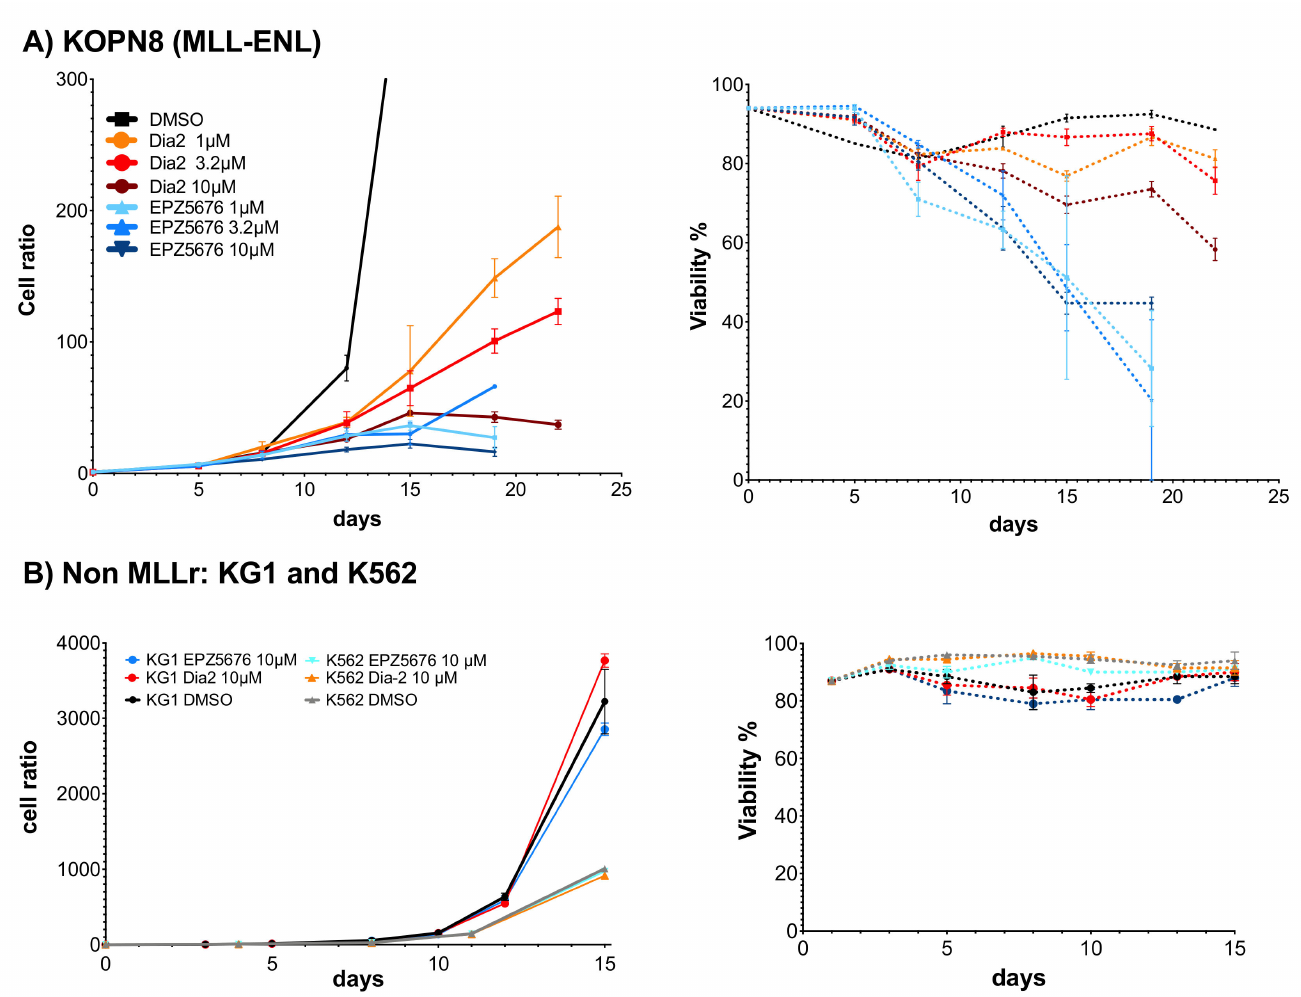
Figure 6. ( A ) Right, growth of KOPN8 cells (MLL-ENL) up to 22 days of incubation with 10 µ M (bordeaux red circles), 3.2 µ M (red circles), 1 µ M (orange circles), of Dia2 and 10 µ M (dark blue triangles), 3.2 µ M (cyan triangles), 1 µ M (sky blue triangles) of EPZ-5676 compared to DMSO treated cells (black squares) were plotted as the ratio amount of cells over initial population. Left, viable cells were counted every 3 to 4 days in the presence of Dia2 , EPZ-5676, or DMSO, and the percentage of viability is reported as dotted curves. Every data point is the result of technical triplicates and biological duplicates. ( B ) Right, growth of non MLLr leukemia cells KG1 (circles) and K562 (triangles) up to 15 days of incubation with 10 µ M (red and orange) of Dia2 and 10 µ M (blue and cyan) of EPZ-5676 compared to DMSO treated cells (black and grey) were plotted as the ratio amount of cells over initial population. Left, viable cells were counted every 3 to 4 days in the presence of Dia2 , EPZ-5676, or DMSO, and the percentage of viability is reported as dotted curves. Every data point is the result of technical triplicates and biological